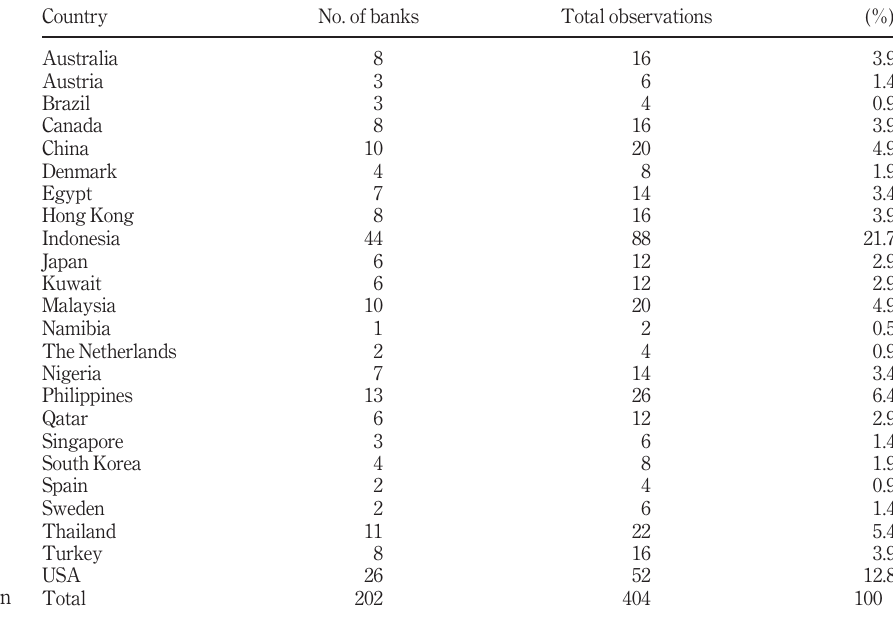
Table 1. Sample distribution